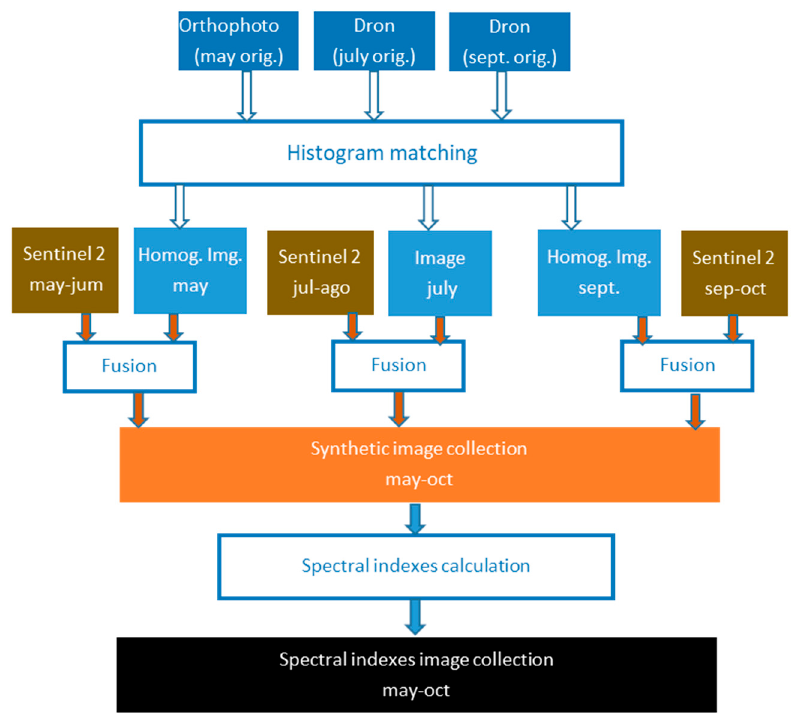
Figure 1. General outline of the process for the fusion of images used in this work.